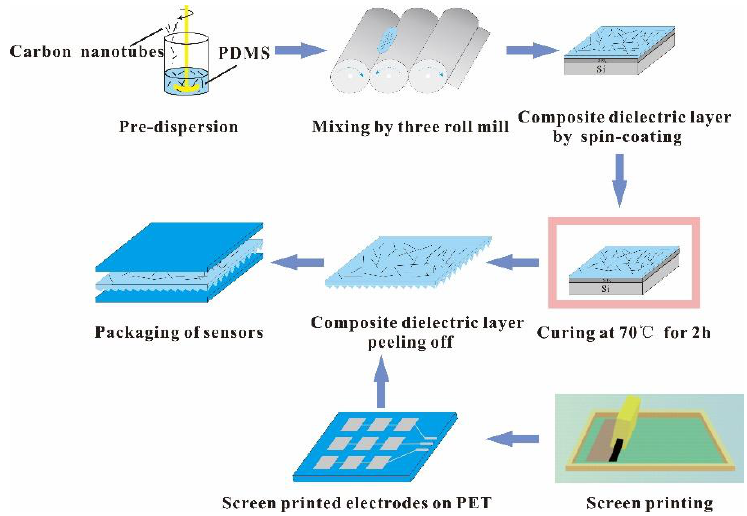
Figure 1. The schematic diagram for the fabrication of the flexible capacitive pressure sensor.